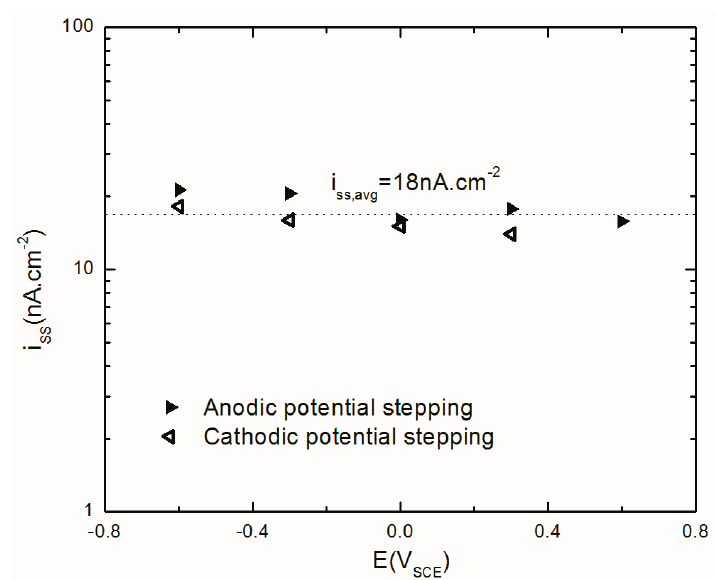
Figure 10. The steady-state anodic current density of AA2098 – T851 alloy in 0.1M NaHCO 3 after 24 h of polarization at different potentials in contact with 1 atm CO 2 (pH = 6.7, 25 °C) during the anodic and cathodic potential stepping obtained from optimization of EIS results. cathodic potential stepping obtained from optimization of EIS results.